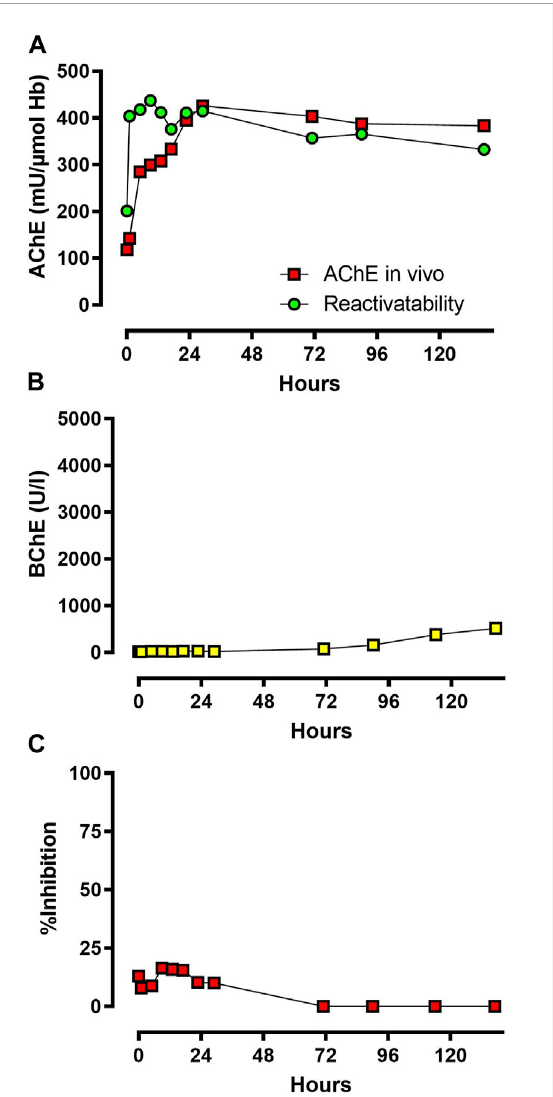
FIGURE 4 (A,B) and (C) : AChE in vivo and reactivatability, BChE in vivo , and inhibitory activity of patient plasma. Time is shown in hours after admission to the toxicological unit. Abbreviations: AChE, acetylcholinesterase; BChE,